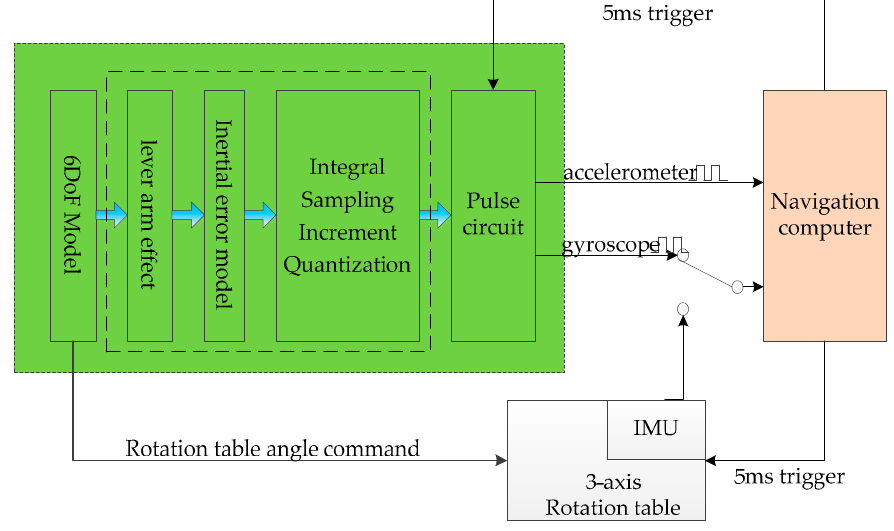
Figure 2. Strapdown inertial measurement unit (IMU) model.